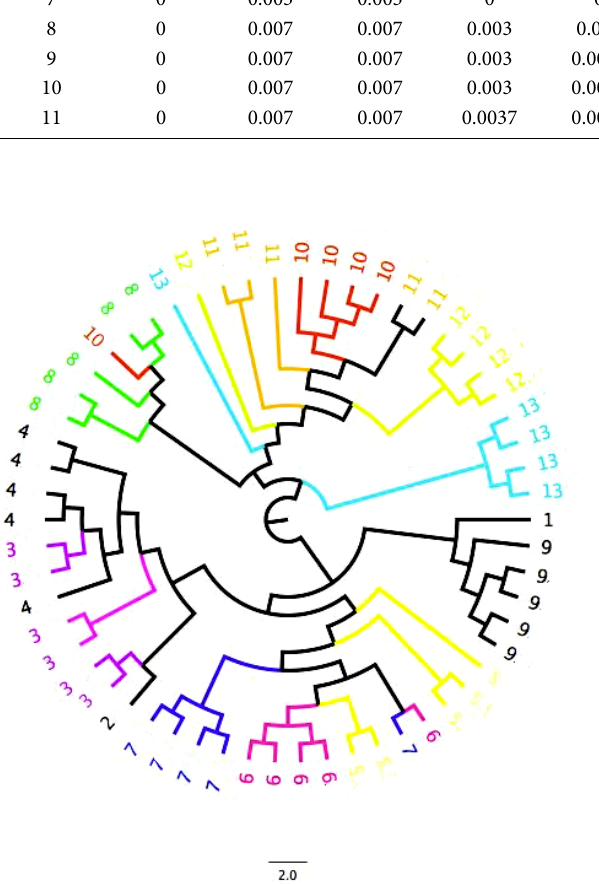
Figure 3. NJ dendrogram of the studied Ziziphus jujube populations based on SRAP molecular markers. (Populations 1-13 are according to Table 1).